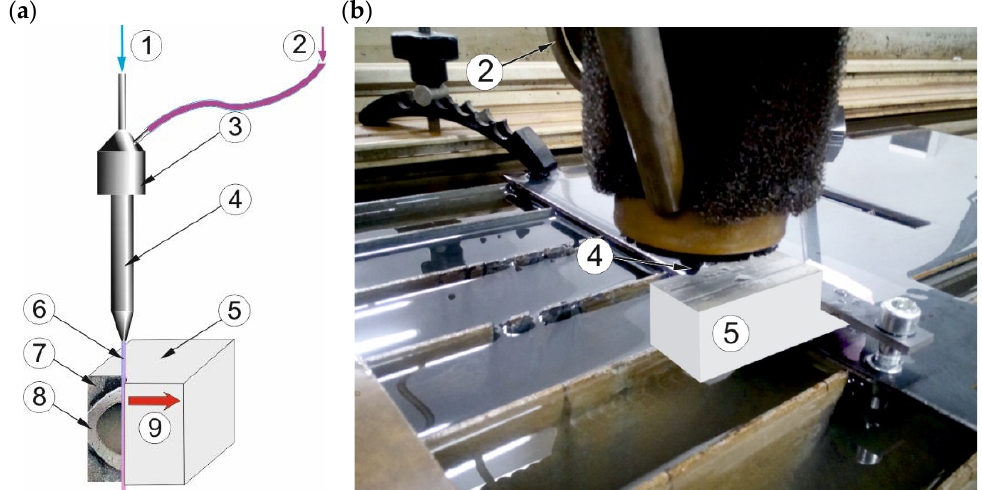
Figure 3. The test rig: ( a ) the schematic, ( b ) the real view; 1. High-pressure water inlet, 2. Abrasive inlet, 3. Mixing chamber, 4. Focusing tube, 5. Cutting material, 6. Abrasive Water Jet, 7. Polymer, 8. Stainless steel, 9. Traverse speed direction.